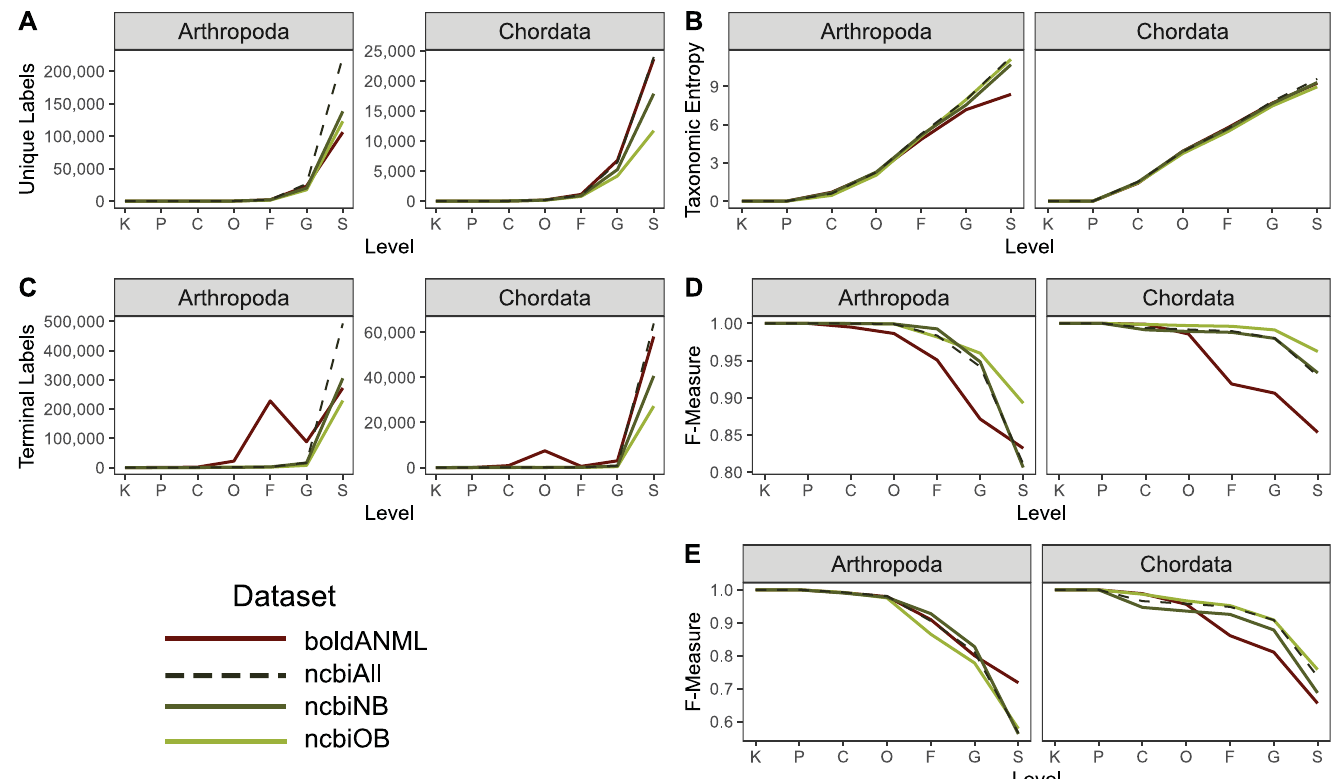
Fig 13. Comparison of taxonomic information and simulated classification accuracy from BOLD and NCBI GenBank COI gene databases for available arthropod and chordate sequences. All sequences were dereplicated and trimmed to a common primer region. NCBI references either contained a cross-reference term to BOLD (“ncbiOB”) or not (“ncbiNB”) or were combined together (“ncbiAll”). A, Number of unique taxonomic labels; B, Taxonomic entropy; C, proportion of unclassified taxa at each rank; D, optimal classification accuracy (as F-Measure) without cross-validation (simulating best possible classification accuracy when the true label is known but classification accuracy may be confounded by other similar hits in the database). E, Classification accuracy with cross-validation. Rank labels on x- axis: K = kingdom, P = phylum, C = class, O = order, F = family, G = genus, S = species.